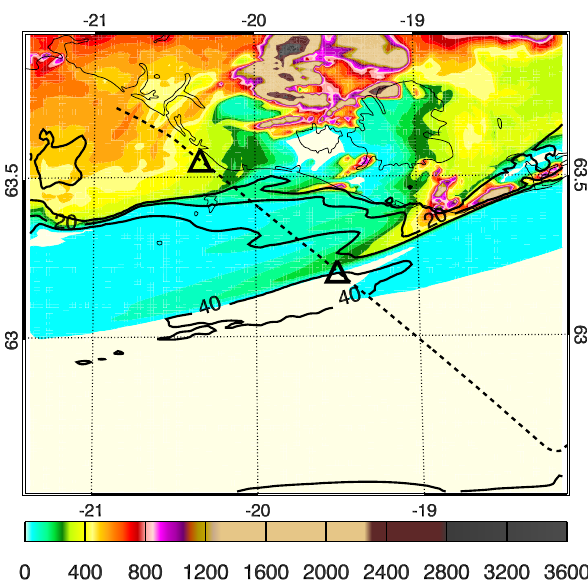
Fig. 9. As in Fig. 8 but for dust mass mixing ratio [µgkg − 1 ] (col- ored shadings) and sea salt mass mixing ratio [µgkg − 1 ] (thick black contours) for particle diameters between 0.04µm and 10µm. Loca- tions of the two mass mixing ratio peaks measured at 400m (see Fig. 12) are indicated by black